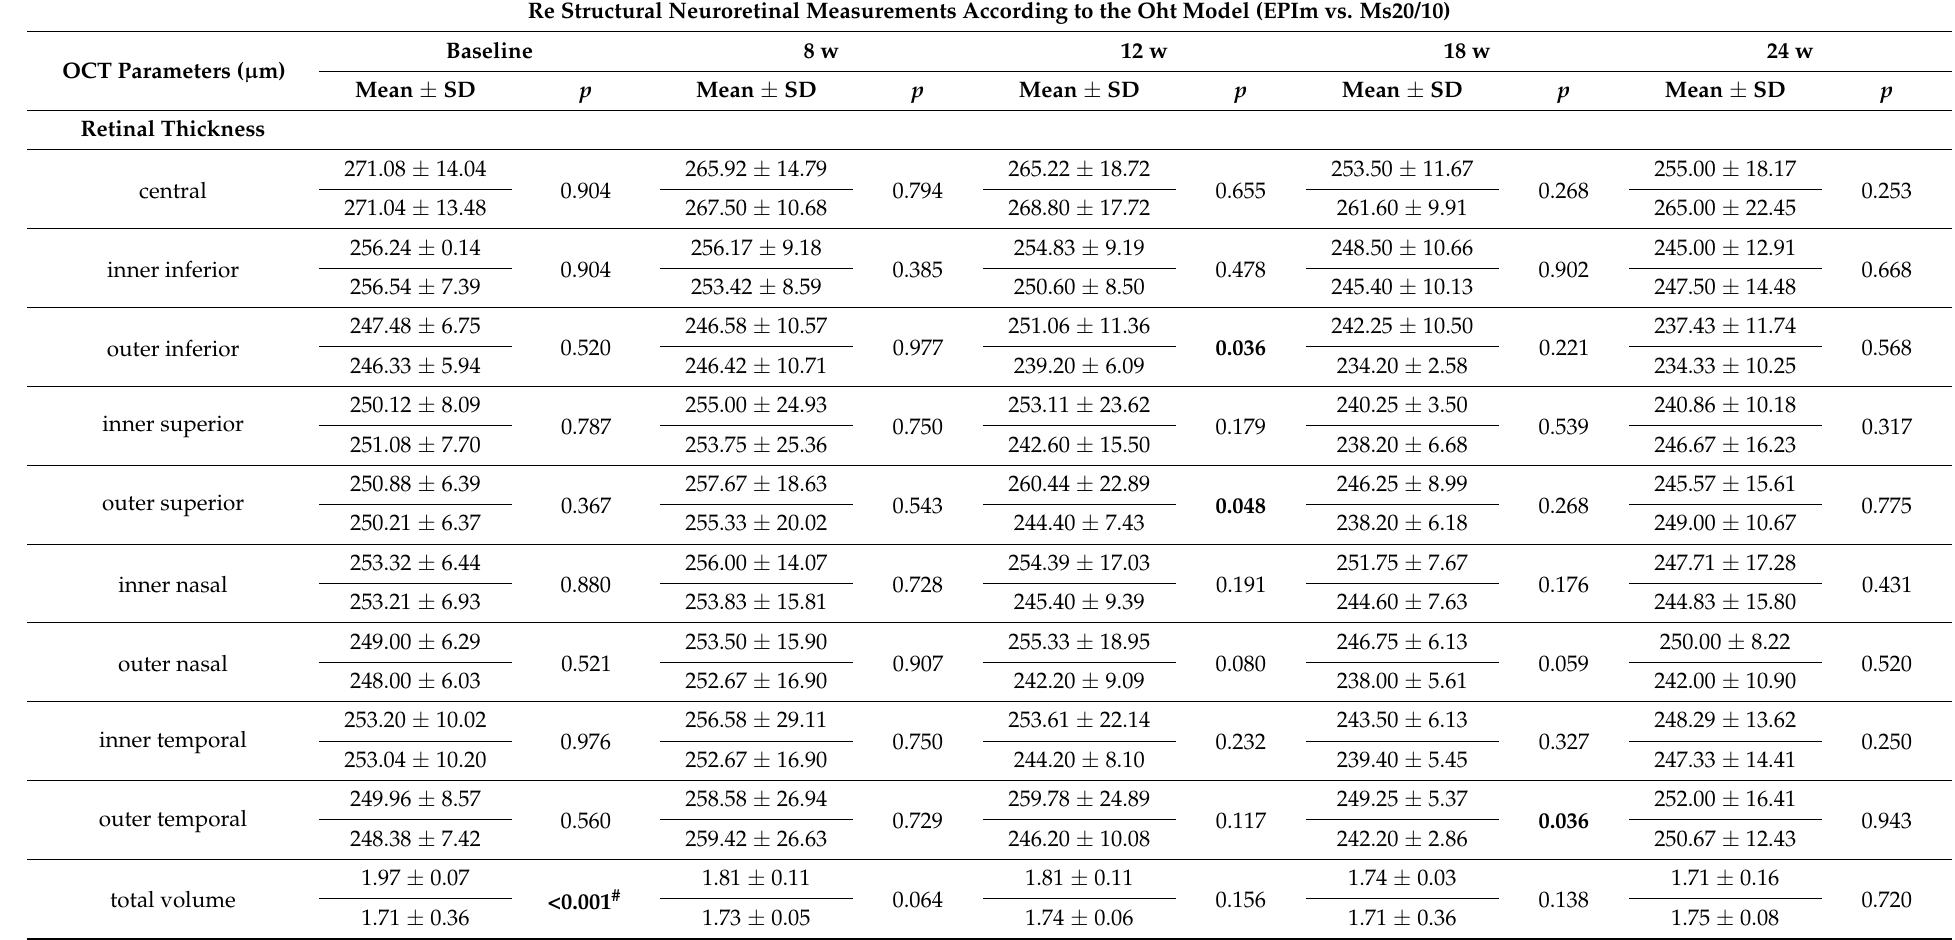
Table 2. Right-eye structural neuroretinal measurements according to the ocular hypertensive models (EPIm vs.